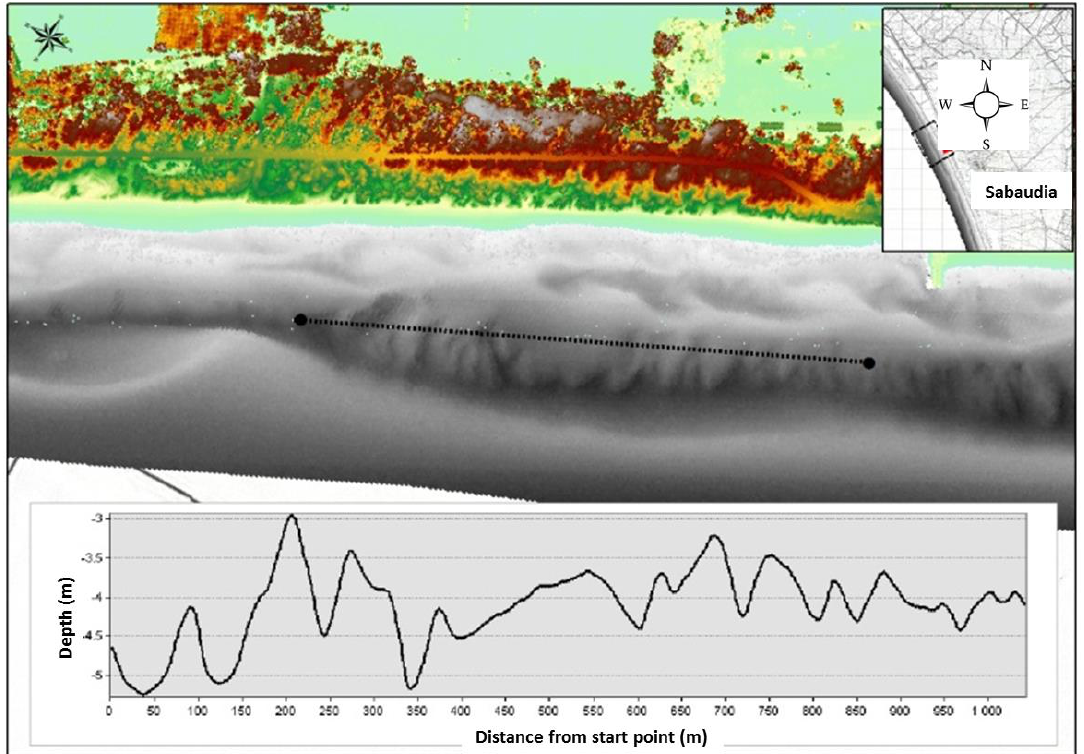
Figure 11. Detailed of the Outer bar (OB). A bathymetric profile (1000 m in length), parallel to the shoreline (black dotted line), demonstrates the asymmetry of the bed forms oriented perpendicular to the outer bar on the shoreface.